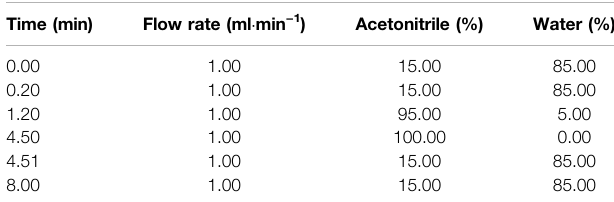
TABLE 1 | The conditions of gradient